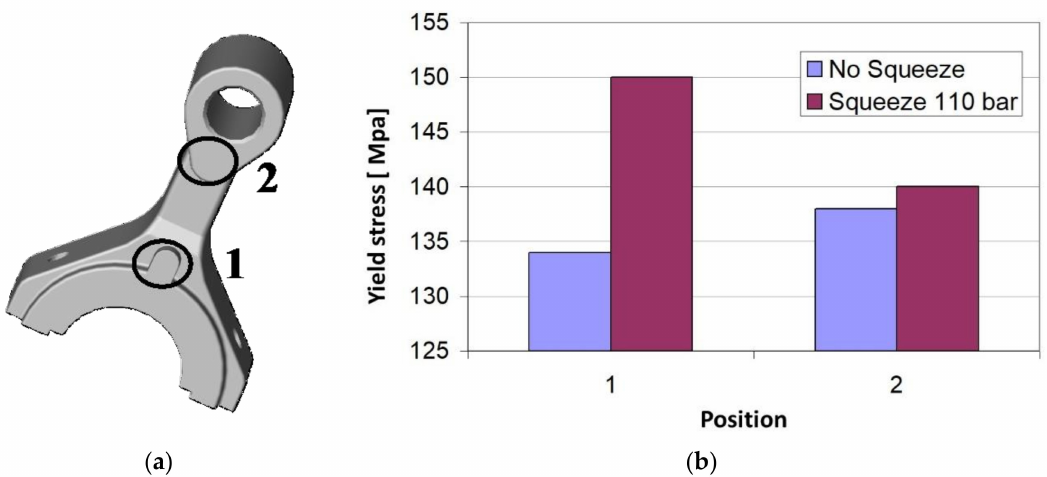
Figure 4. Yield stress determined through FIMEC test in the points 1 and 2 of the crank ( a ) produced with and without local pressure of the pin in the point 1 ( b